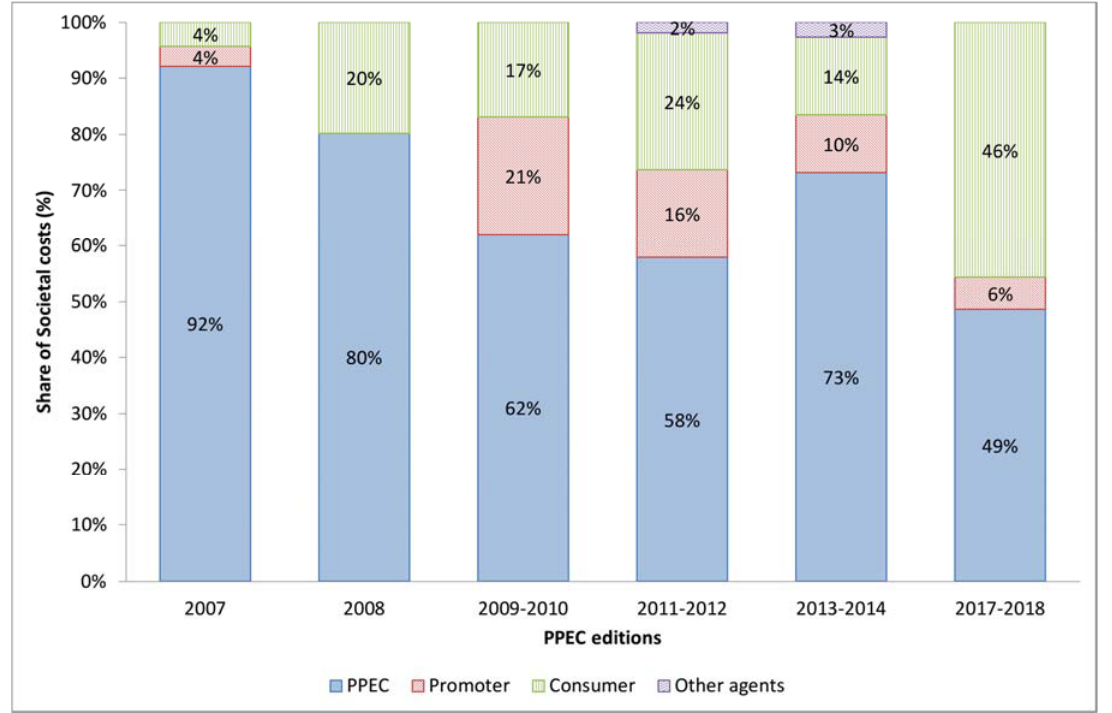
Figure 11. Share of societal costs of the selected tangible measures for the Households consumption segment, in each PPEC edition [19–26].